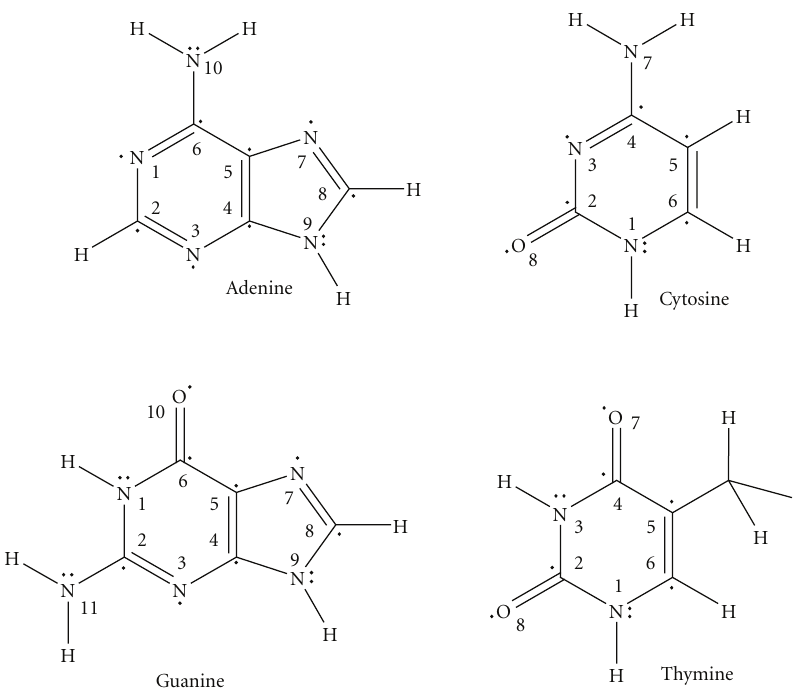
Figure 1: The single bases of A, G, C, and T. Here dots ( • ) mean π